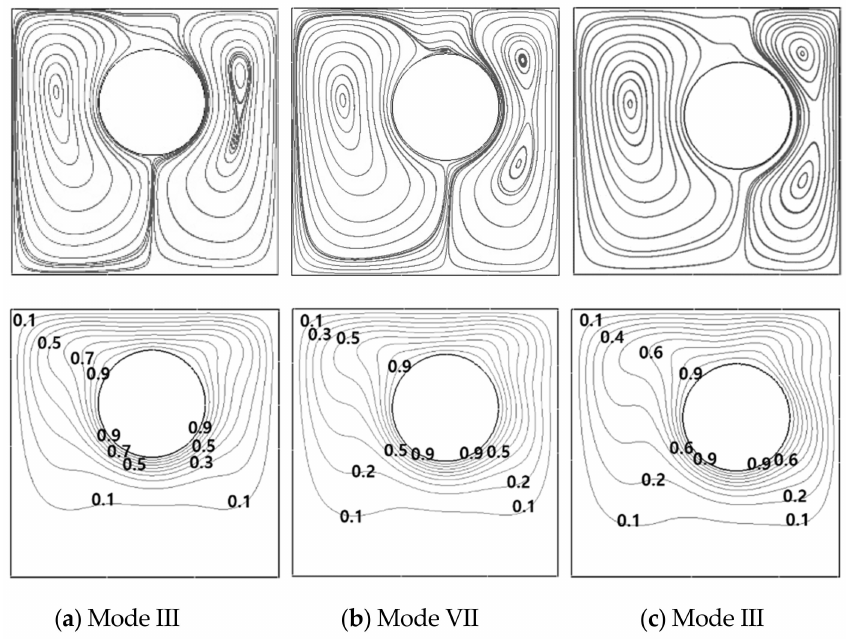
Figure 17. Streamlines (upper row) and isotherms (lower row) at ( a ) θ = 80 ◦ ( b ) θ = 60 ◦ and ( c ) θ = 40 ◦ at a fixed r = 0.15 L for Ra = 10 5 .